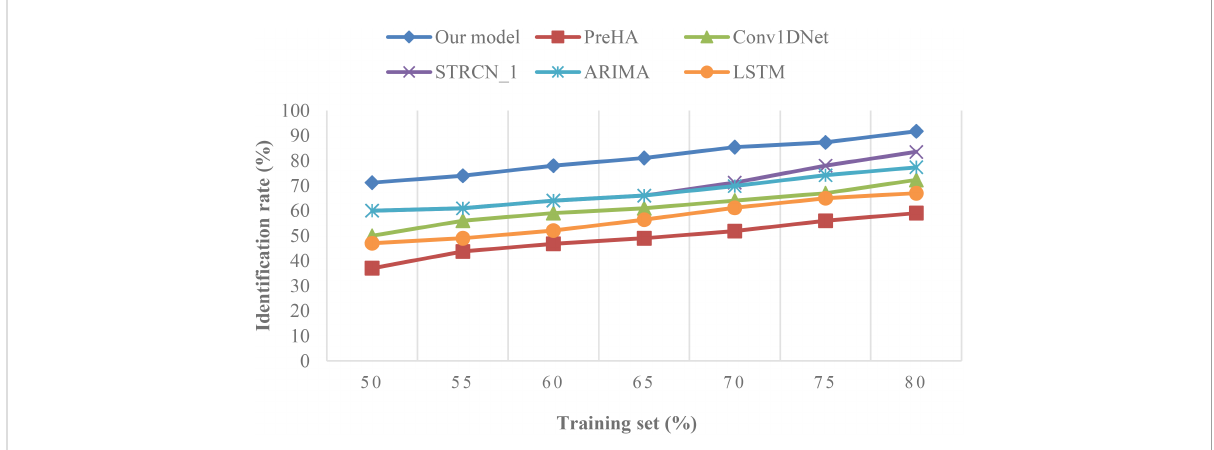
FIGURE 8 Performance analysis of the proposed hybrid model with the selected baseline